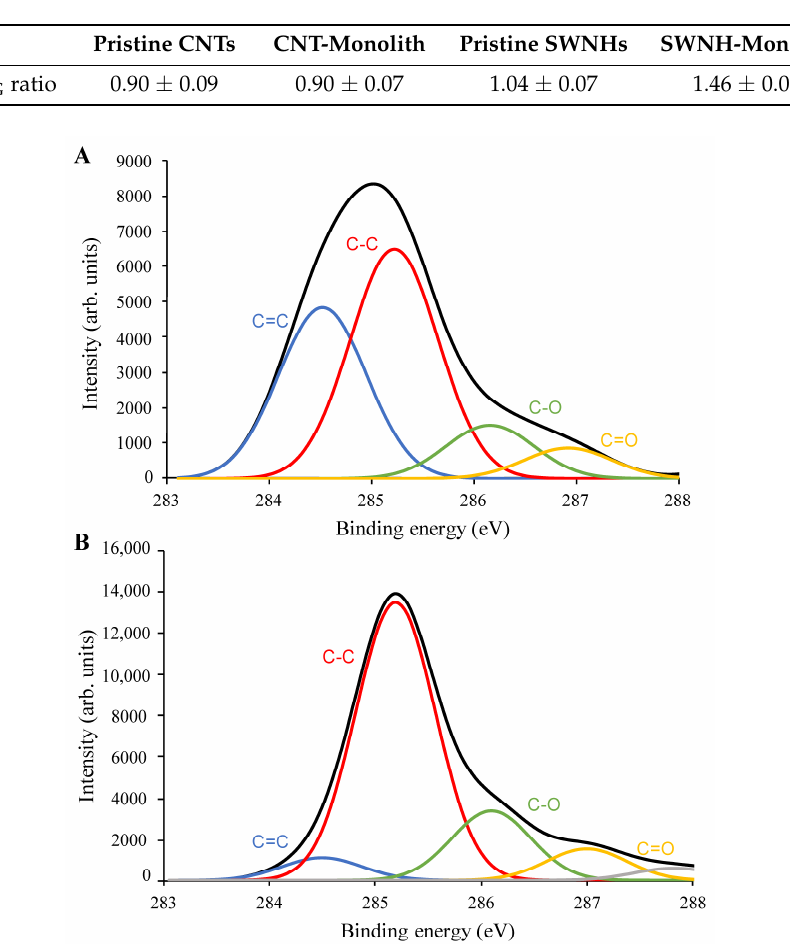
Figure 7. X-ray photoelectron spectroscopy C1s spectra and deconvolution results of ( A ) pristine SWNHs, and ( B ) SWNH-monolith.